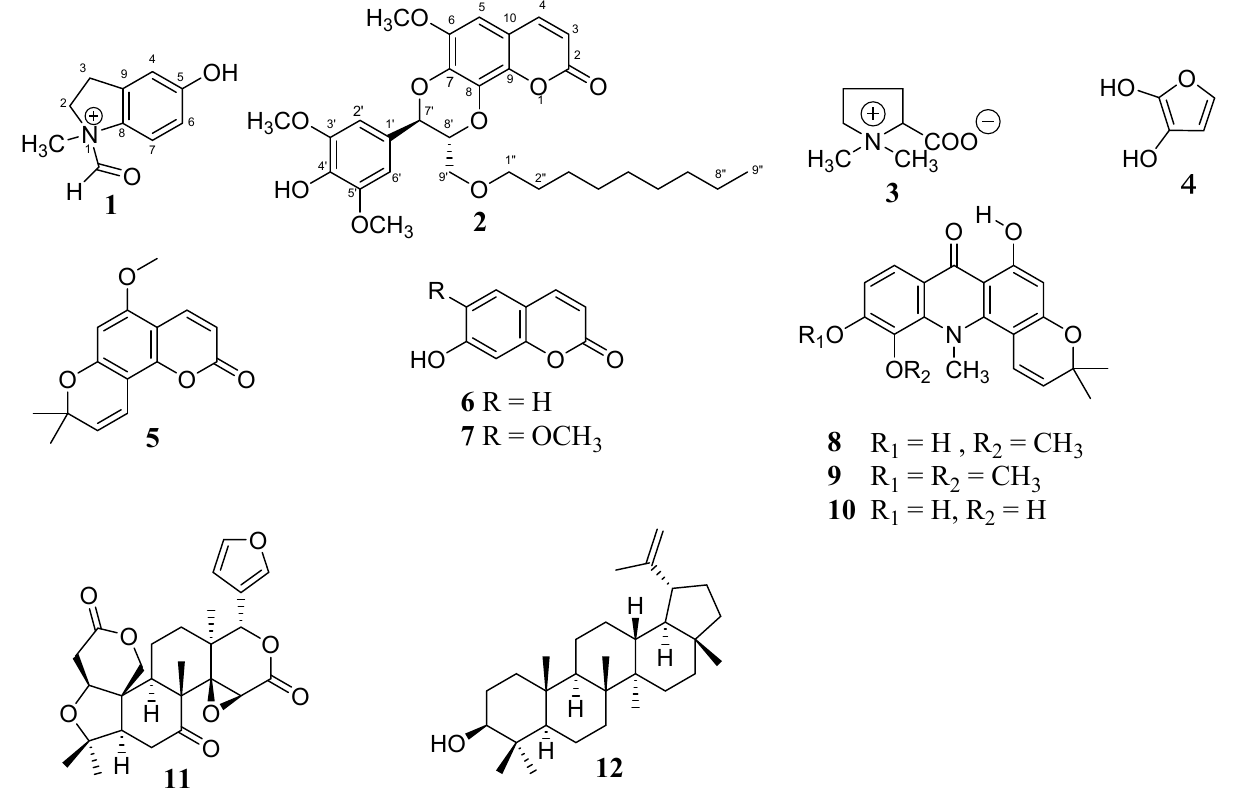
Figure 1. Structures of compounds 1–12. Table 1. 1 H (500 MHz) and 13 C (125 MHz) data of 1-formyl-5-hydroxy- N -methylindolin-1-ium ( 1 ) in DMSO-d 6 .